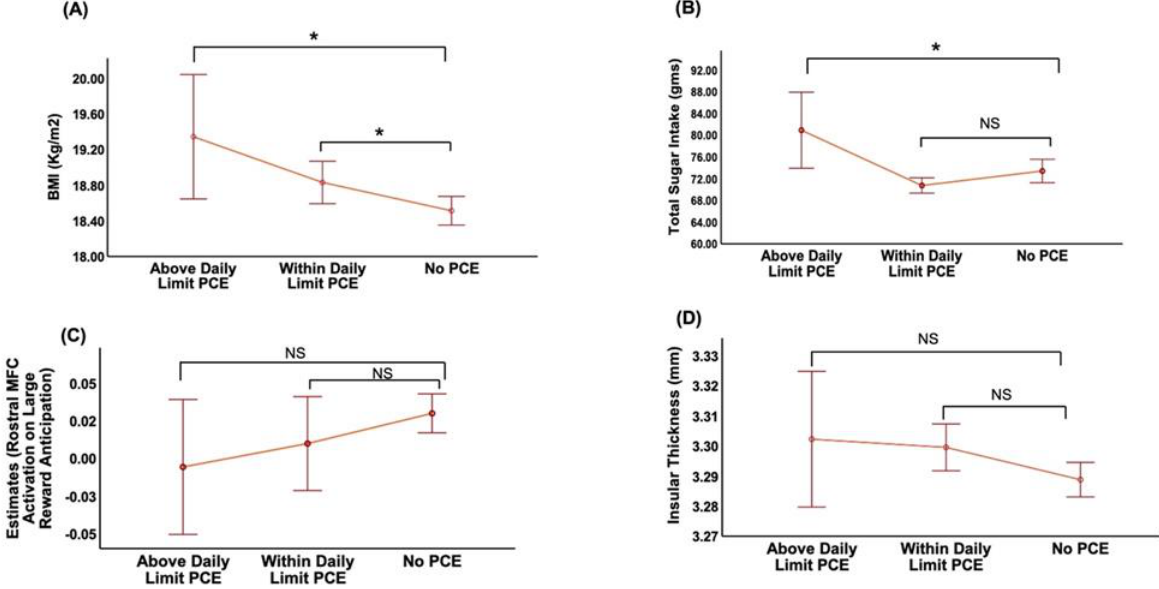
Figure 2. Line plots illustrating the association outcomes of BMI ( A ), total sugar intake ( B ), rostral middle frontal cortex activation on large reward anticipation during MID task-fMRI ( C ), insular thickness ( D ) in various daily prenatal caffeine exposure (PCE) (vs. no PCE) groups after controlling for the confounding effects of age, sex, child race/ethnicity, highest household education, household income and physical activity across different linear mixed-effect models. Here, * denotes statistical significance with p < 0.05 on Bonferroni correction, while NS denotes no statistical significance.